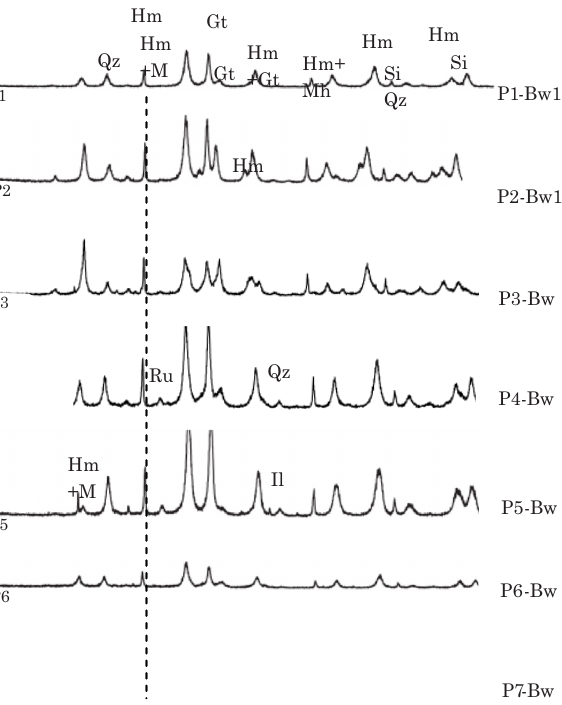
Figura 3. Difratogramas de raios-X da fração argila concentrada em Fe, com padrão de Si, de horizontes B dos solos (lâminas não orientadas) (Gt: goethita; Hm: hematita; Il: ilmenita;